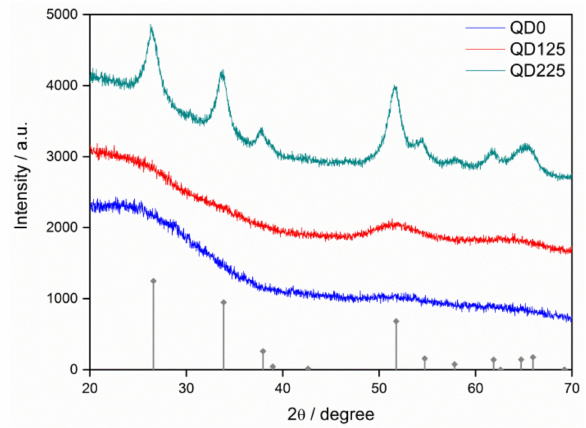
Figure 2. X-ray diffraction patterns of QD0, QD125, and QD225 samples with the standard pattern of SnO 2 semiconductors.